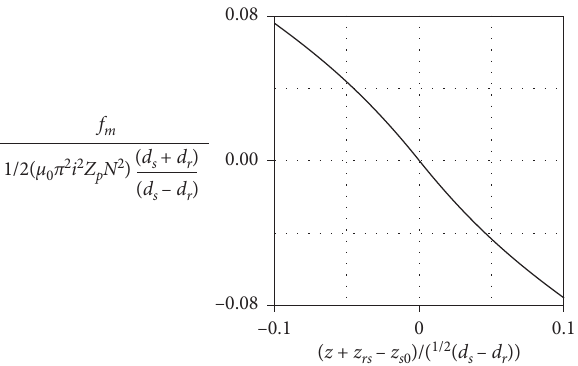
Figure 11: Axial force magnitude on rotor generator.